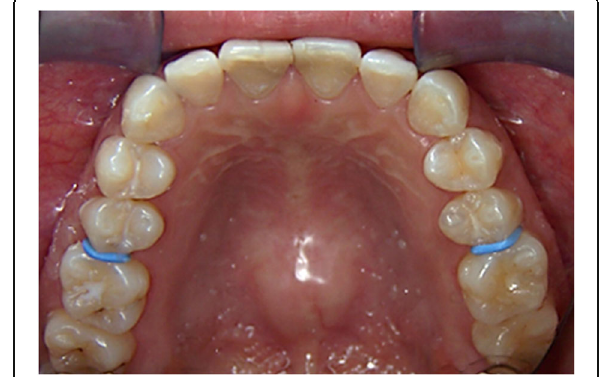
Fig. 3 Intraoral photograph. An upper occlusal view showing the orthodontic elastomeric separators placed between the maxillary second premolars and first